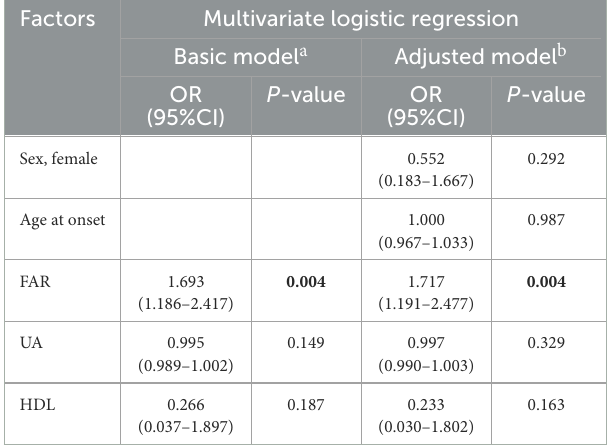
TABLE 7 Multivariate logistic regression for assessing the association of fibrinogen-to-albumin ratio with disease severity. Factors Multivariate logistic